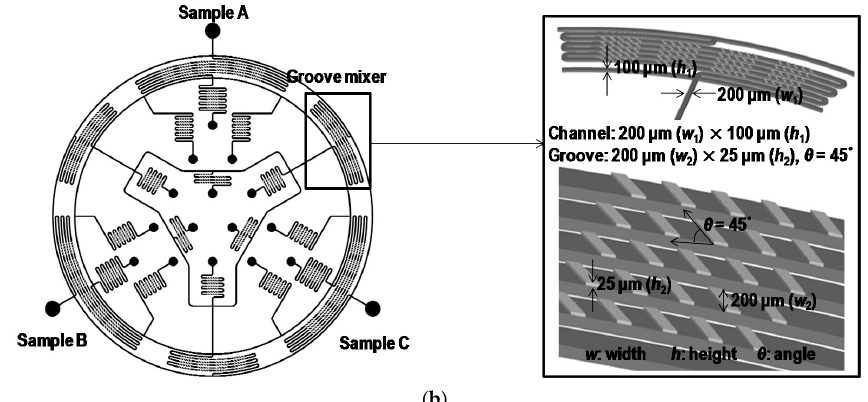
Figure 2. ( a ) Equivalent electrical circuit for modeling of proposed microfluidic network using electric-fluidic analogy. ( b ) Geometrical details of the proposed microfluidic device designed by the modeling.